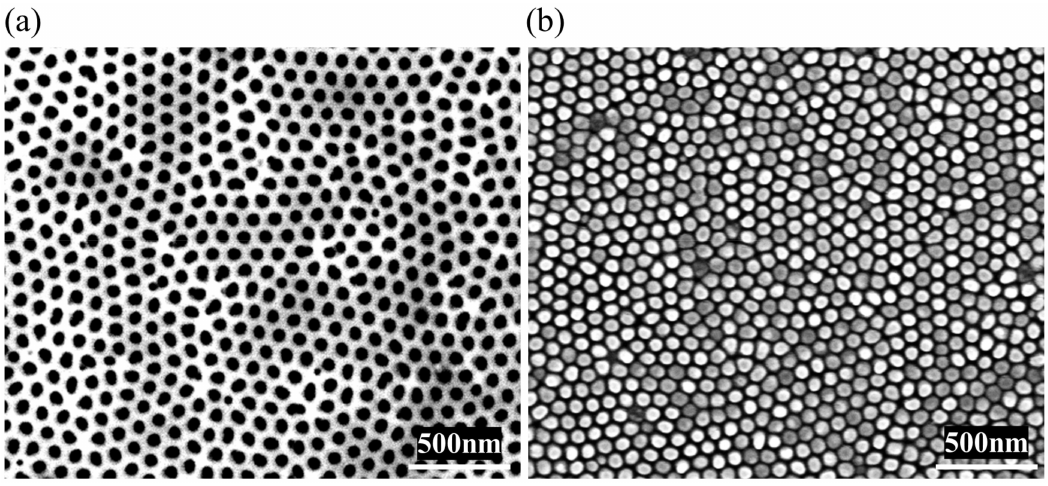
Figure 7. ( a ) Top-viewed SEM image of the anodic aluminum oxide (AAO) mold; and ( b ) top-viewed SEM image of the imprinted PMMA layer on polyethylene terephthalate (PET) substrate.